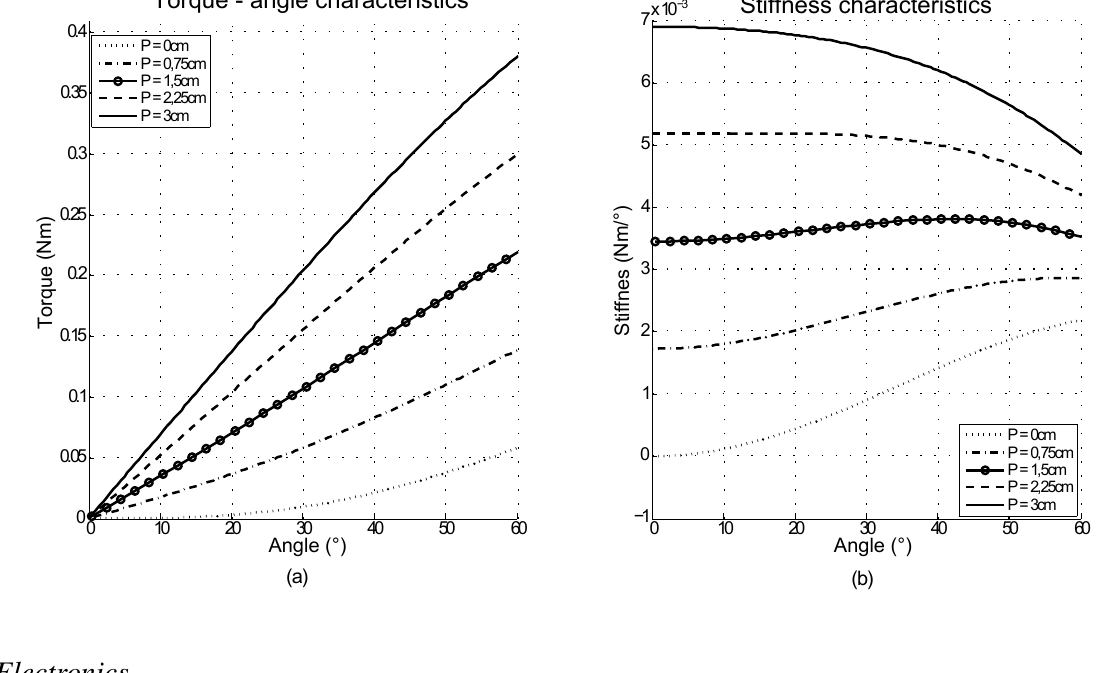
Figure 9. The torque-angle ( a ) and stiffness ( b ) characteristic of both MACCEPAs for different